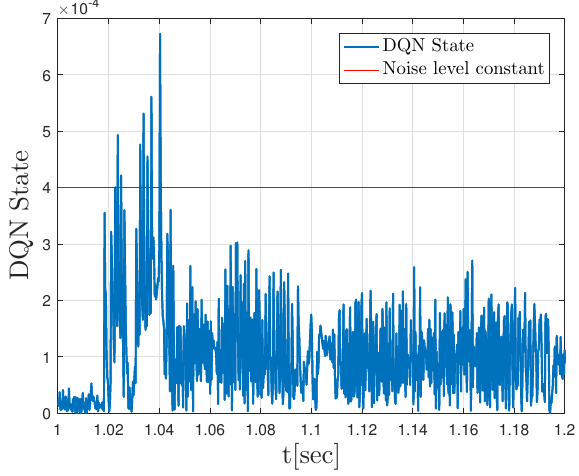
Figure 11. DQN state